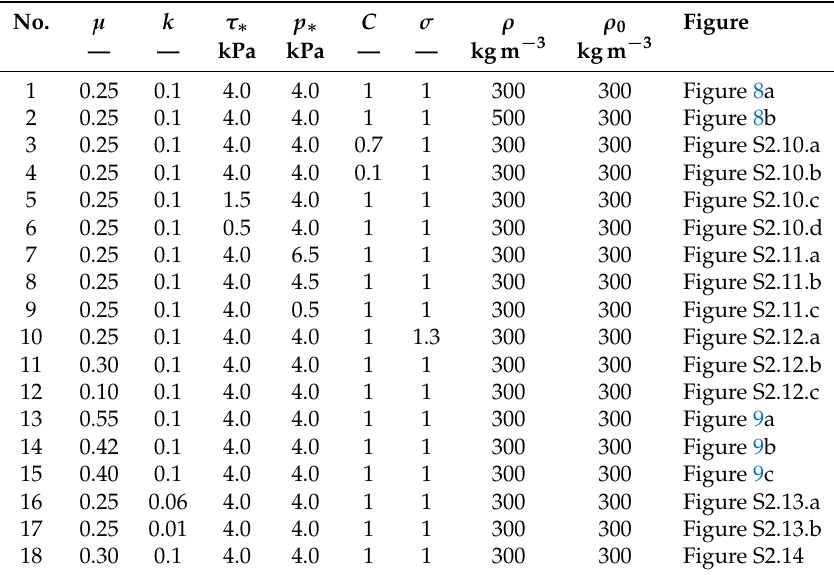
Table 3. Parameter values of numerical simulations with the full model for investigating the influence of entrainment on avalanche dynamics ([1], Notes 8 and 24). Figure numbers preceded by ‘S2’ refer to the Supplementary Materials Document